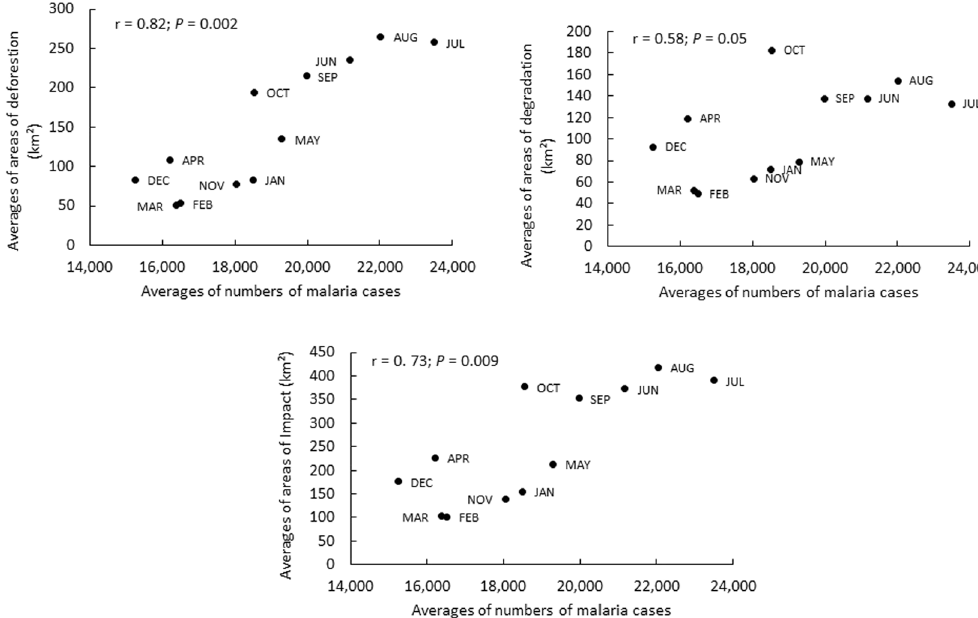
Figure 2. Graphs of dispersion between the number of malaria cases and the areas affected by deforestation, degradation and impacted forest with areas of less than 5 km², between 2009–2015.